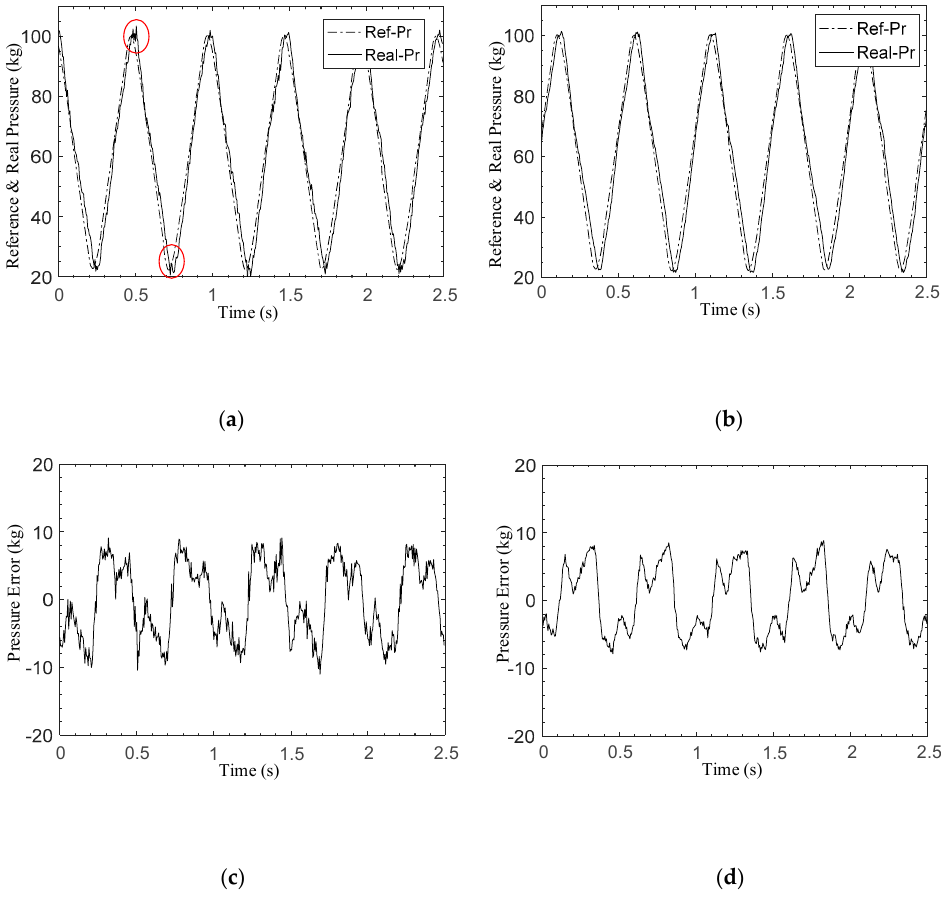
Figure 9. Comparison of EMA controller performance. ( a ) Pressure without the fuzzy corrector; ( b ) pressure with the fuzzy corrector; ( c ) pressure error without the fuzzy corrector; ( d ) pressure error with the fuzzy corrector;.